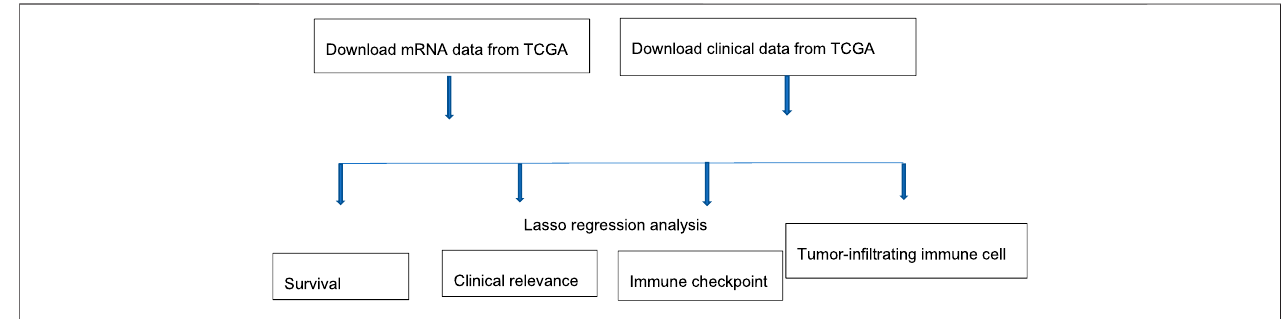
FIGURE 1 | Study process.